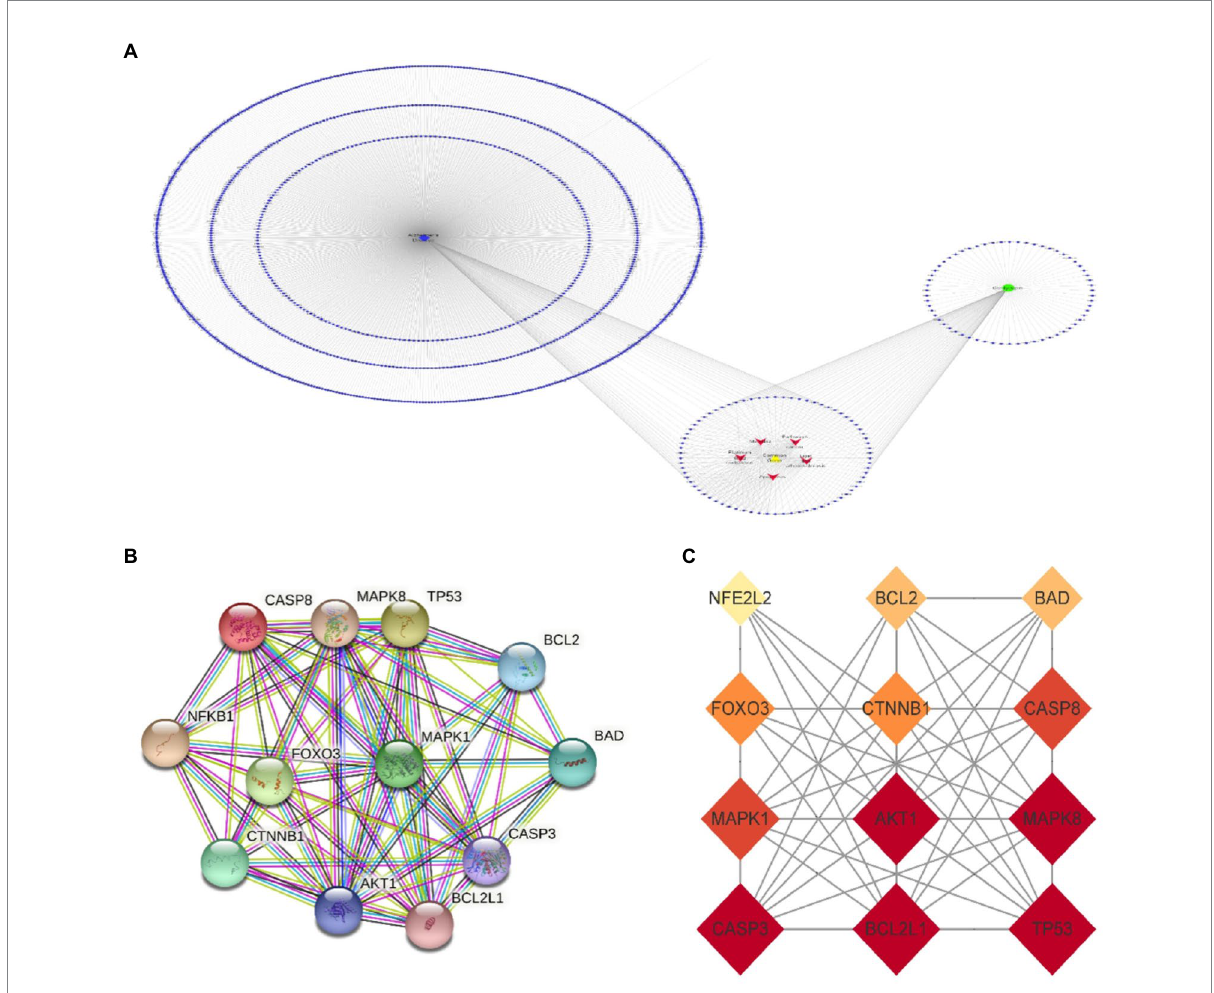
FIGURE 4 Cordycepin-Alzheimer disease-pathway target network (A) ; 12 key targets of Cordycepin-anti-Alzheimer PPI network (B,C)